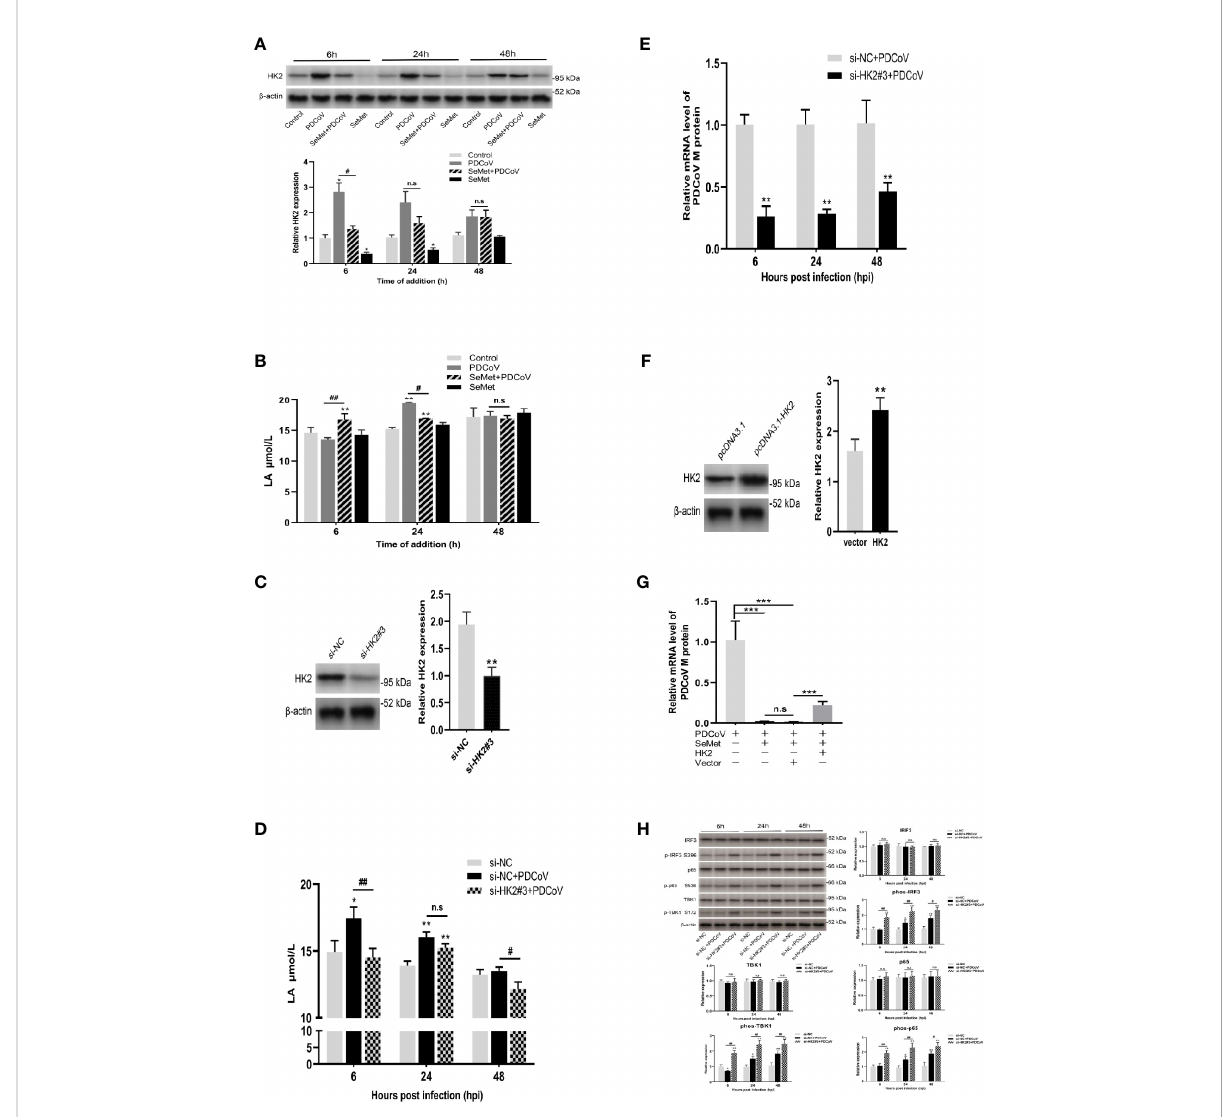
FIGURE 2 HK2 plays an important role in PDCoV replication. (A) LLC-PK1 cells were treated with PDCoV (100 TCID 50 ) and SeMet (150 m M) for 6, 24, and 48 h, and the level of HK2 was determined by and Western blot(n=3). (B) The LA level was measured by ELISA (n=3). (C) The HK2 protein expression was determined by Western blot in LLC-PK1 cells treated with siRNA-NC and siHK2 (n=3). (D) HK2 inhibition-induced LA expression after PDCoV infection. LA expression in LLC-PK1 cells was determined by ELISA (n=4). (E) Cells were infected with PDCoV for 6, 24, and 48 h post infection (hpi), after transfection with siRNA-NC or siHK2. Expression level of viral mRNAs was analyzed by qRT-PCR (n=8). (F) The HK2 protein expression was determined by Western blot in LLC-PK1 cells when transfected with pcDNA3.1-vector or pcDNA3.1-HK2 (n=3). (G) Cells were transfected with pcDNA3.1-vector or pcDNA3.1-HK2, followed by treatment with SeMet and PDCoV. Viral mRNA expression was analyzed by qRT-PCR (n=6). (H) HK2 inhibition-induced RLR signal proteins expression after PDCoV infection. The TBK1, phos-TBK1 (Ser172), IRF3, phos- IRF3 (Ser396), p65, or phos-p65 (Ser536) protein levels were analyzed by Western blot (n=3). Means ± SD are shown. Statistical signi fi cance was determined by Student t test. ***, P <0.001; **, P <0.01; *, P <0.05; ## , P <0.01; # , P <0.05; n.s: not signi fi cant. All experiments were repeated at least twice and representative results are